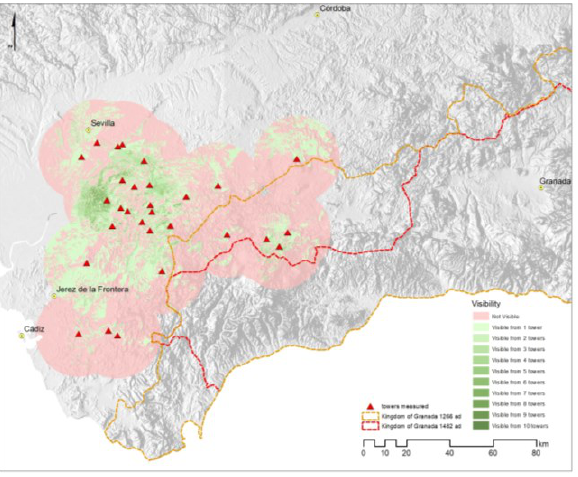
Figure 5: Visibility study from the towers, considering a limited distance of 20km and the earth´s curvature.